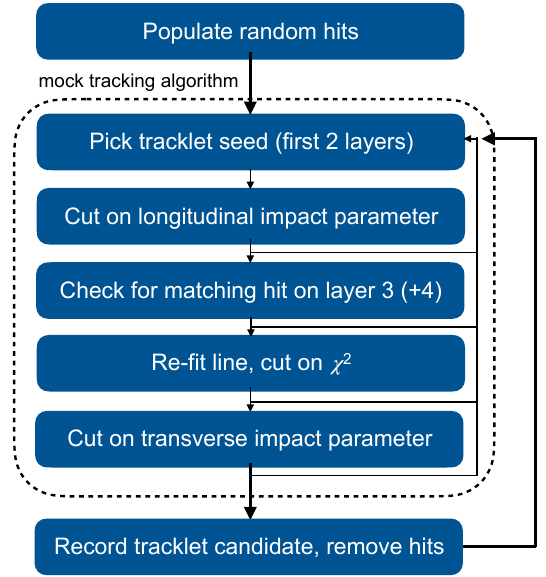
Figure 7 . A visual representation of our simplified tracklet reconstruction